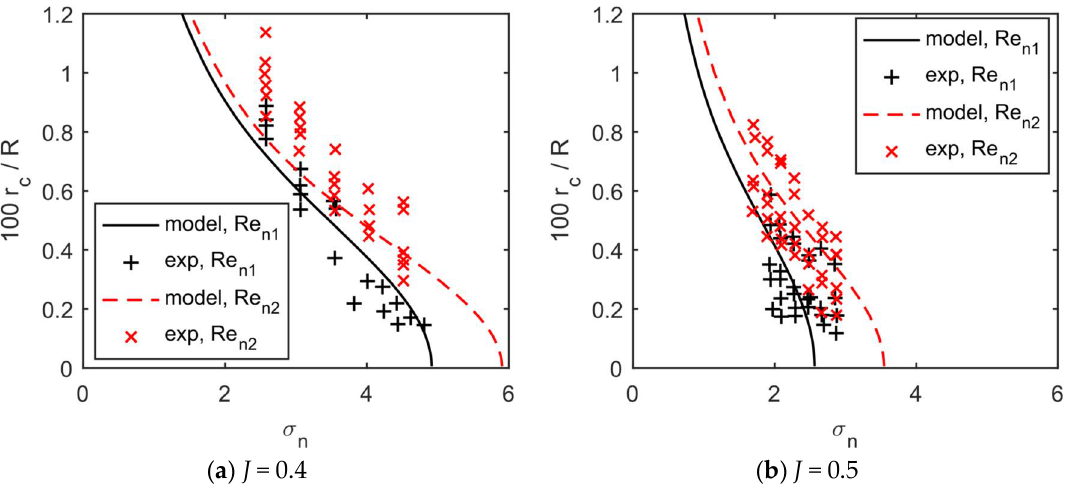
Figure 4. Measured and fitted cavity size variation for a propeller at two advance ratios. Experiments by Kuiper [30], Re n 1 = 1.38 × 10 6 , Re n 2 = 2.76 × 10 6